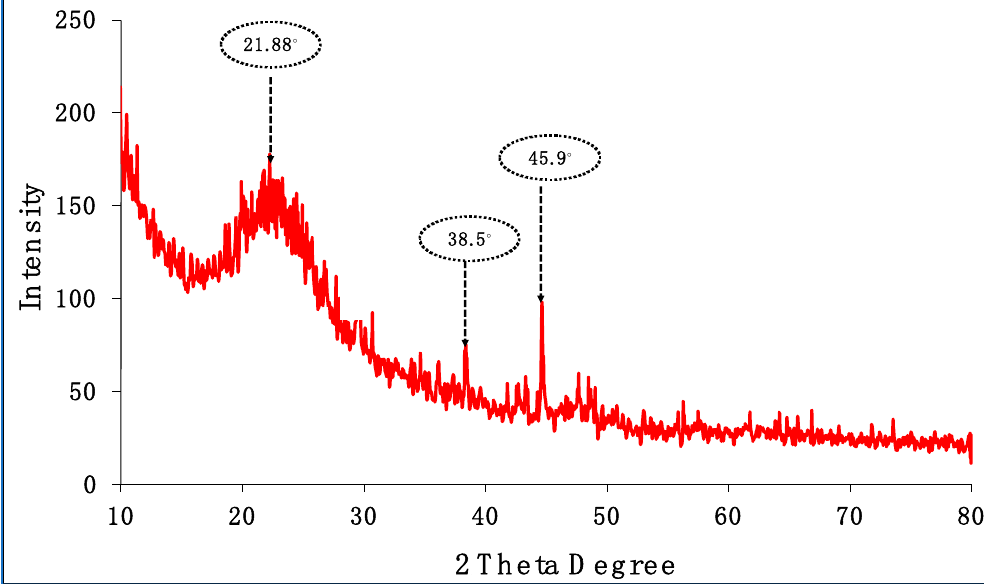
Figure 3. XRD of SiO 2 -NPs.